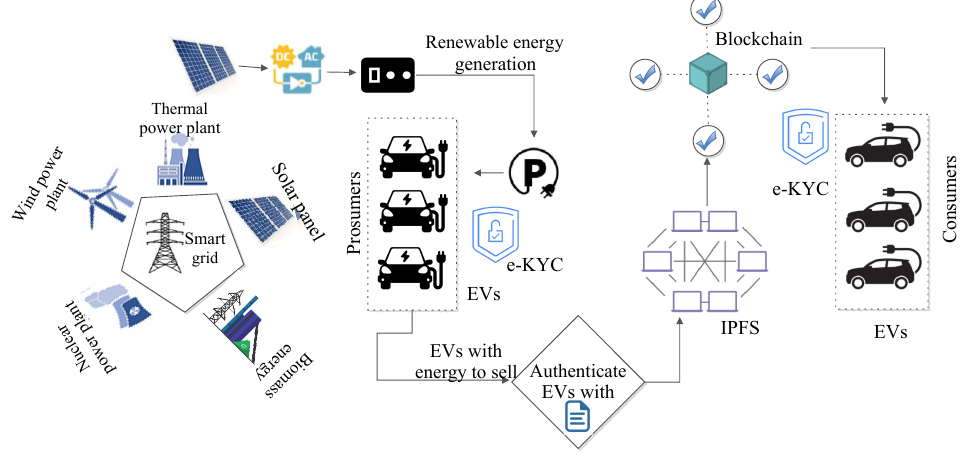
Figure 2. System model of the proposed